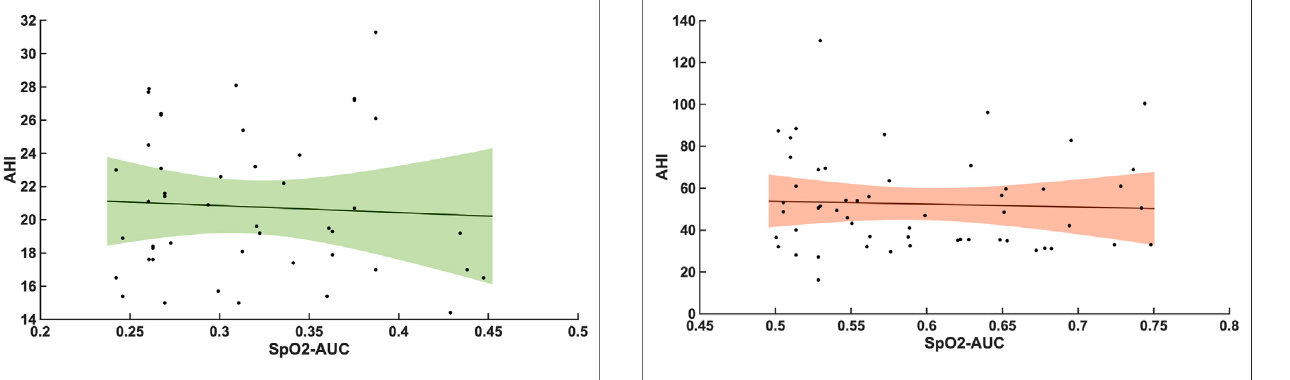
FIGURE 6 | Shows the linear regression results between the AHI and SpO2-AUC for patients with AHI 15 – 30/h of TST. The green margins indicate the standard deviation for the correlation and the black dots indicate each subject in this group. r = -0,0580/ p = 0,6987/ n = 47.